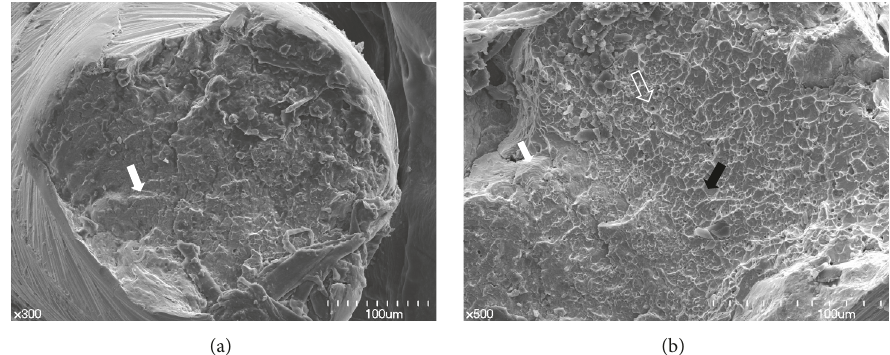
Figure 4: Fracture surface of as-received (a) and HF-treated (b) K3 instruments. Both surfaces revealed characteristic patterns of cyclic fatigue fractures with multiple lines (white arrows in (a, b)) and cone and cup appearance (black arrows in (b)). Pore-like structures were also shown (unfilled white arrow in (b)). The multiple lines pointed to by white arrow show the initiation site for the fatigue fracture